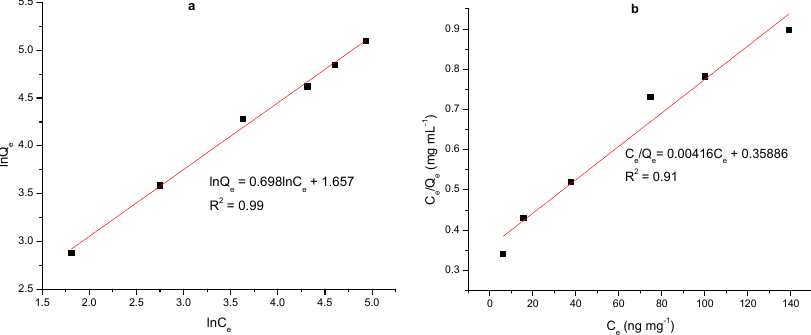
Figure 6. Freundlich model ( a ) and Langmuir model ( b ) MIP1.